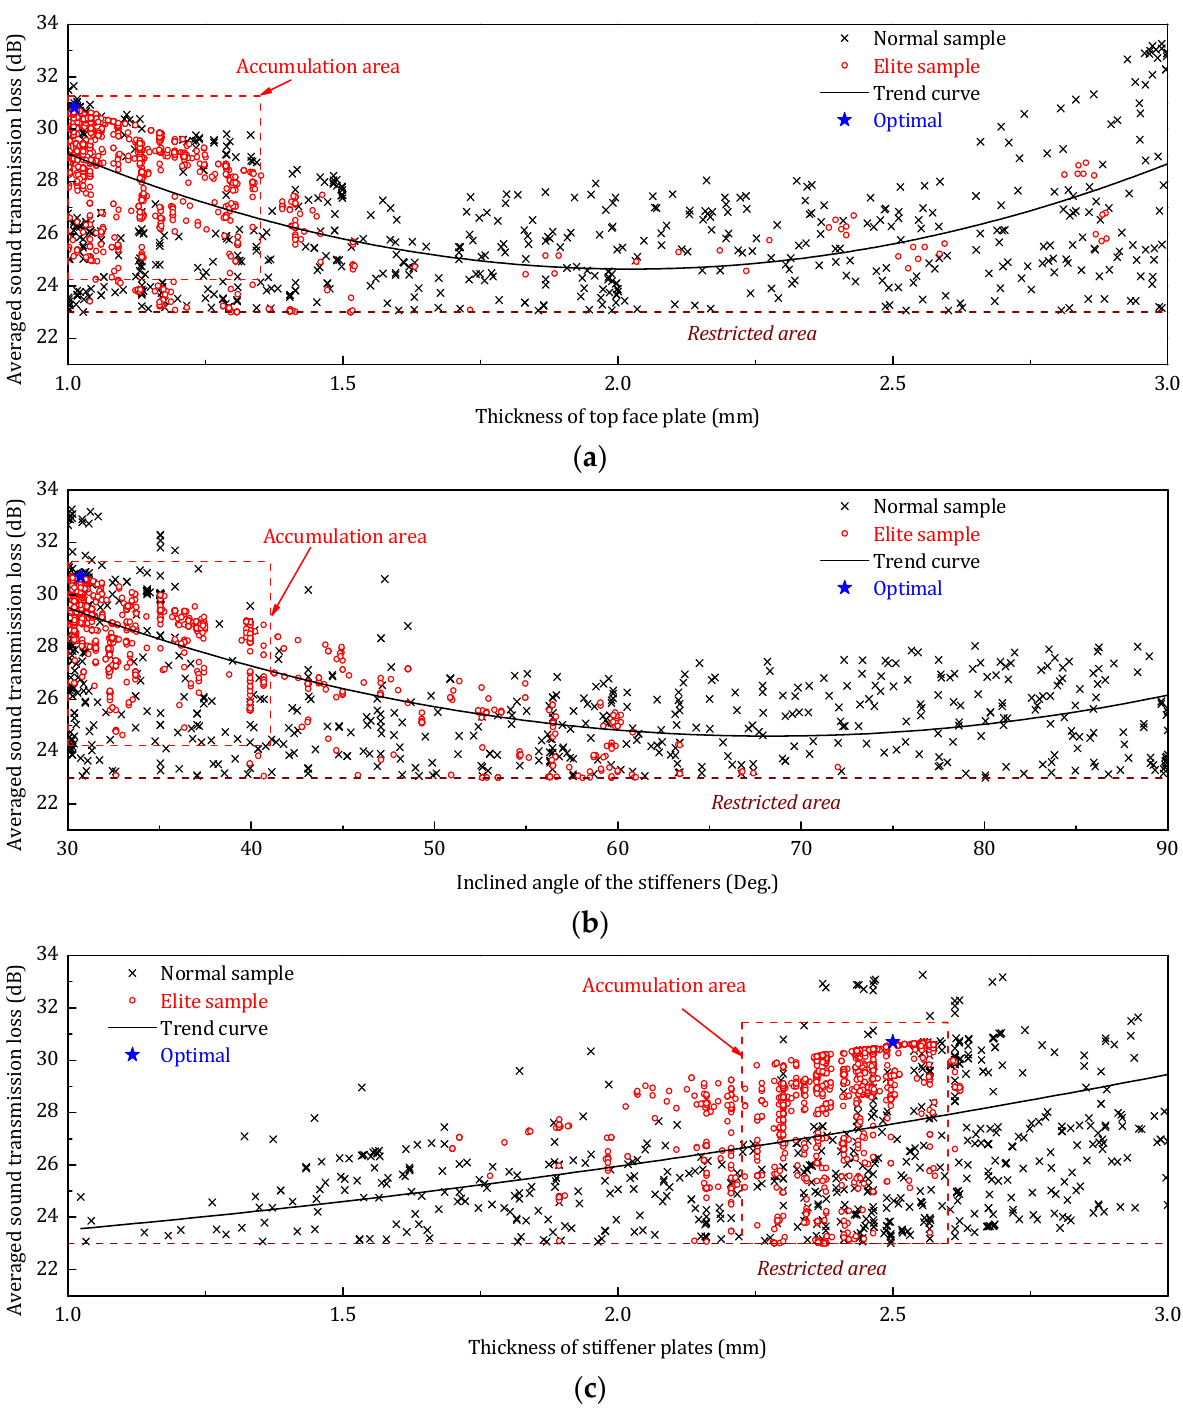
Figure 21. Optimization samples distribution of design parameters (low-frequency optimization). ( a ) Optimization samples distribution of h t ; ( b ) Optimization samples distribution of φ ; ( c ) Optimization samples distribution of h s .